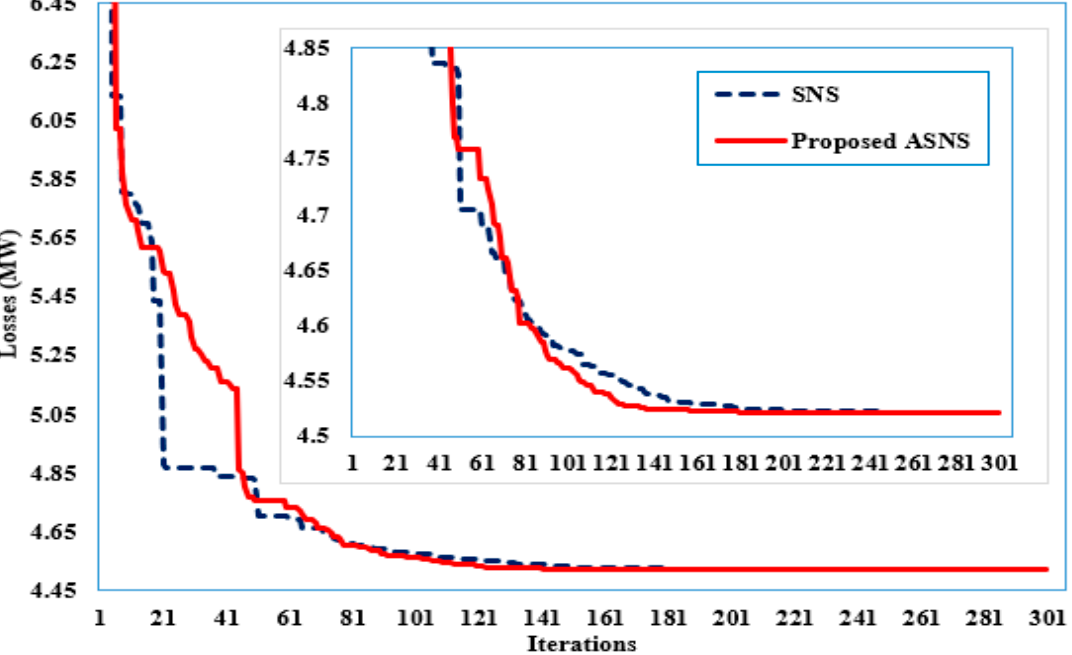
Figure 3. Convergence features of the ASNS and SNS for Case 1 of the IEEE 30-bus grid.